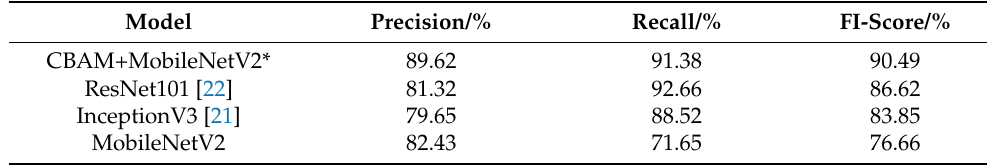
Figure 9. Confusion matrix of rock image classification with MobileNetV2 model fused with attention mechanism. Table 5. Model evaluation index results.